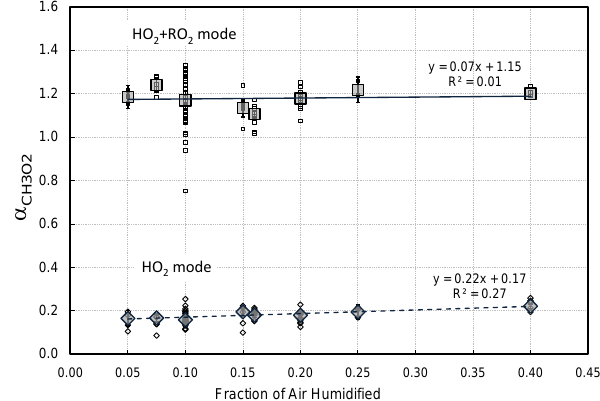
Fig. 4. Dependence of α CH on the fraction of calibrator air that 3 O 2 has been saturated for the HO 2 +RO 2 and HO 2 modes. Smaller points show individual α CH measurements, and larger points are 3 O 2 the error-weighted means of the α CH determinations at each hu- 3 O 2 midity. Error bars show the error-weighted standard